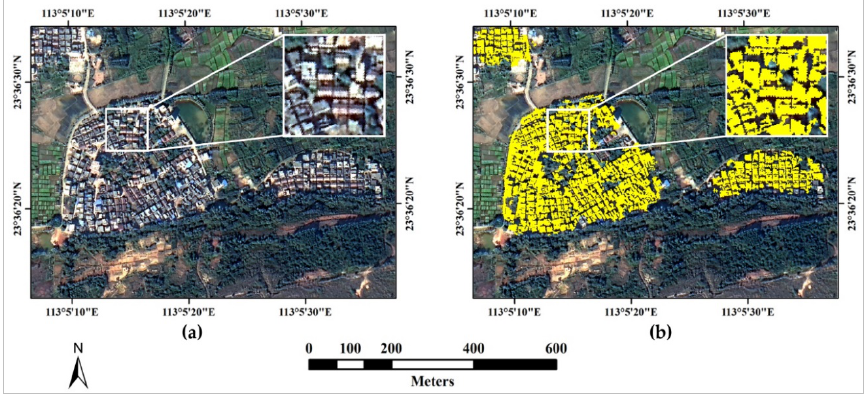
Figure 4. Building detection results. ( a ) Original very high resolution (VHR) remote sensing imagery; ( b ) Building map (marked with yellow-colored areas) detected by our proposed method.